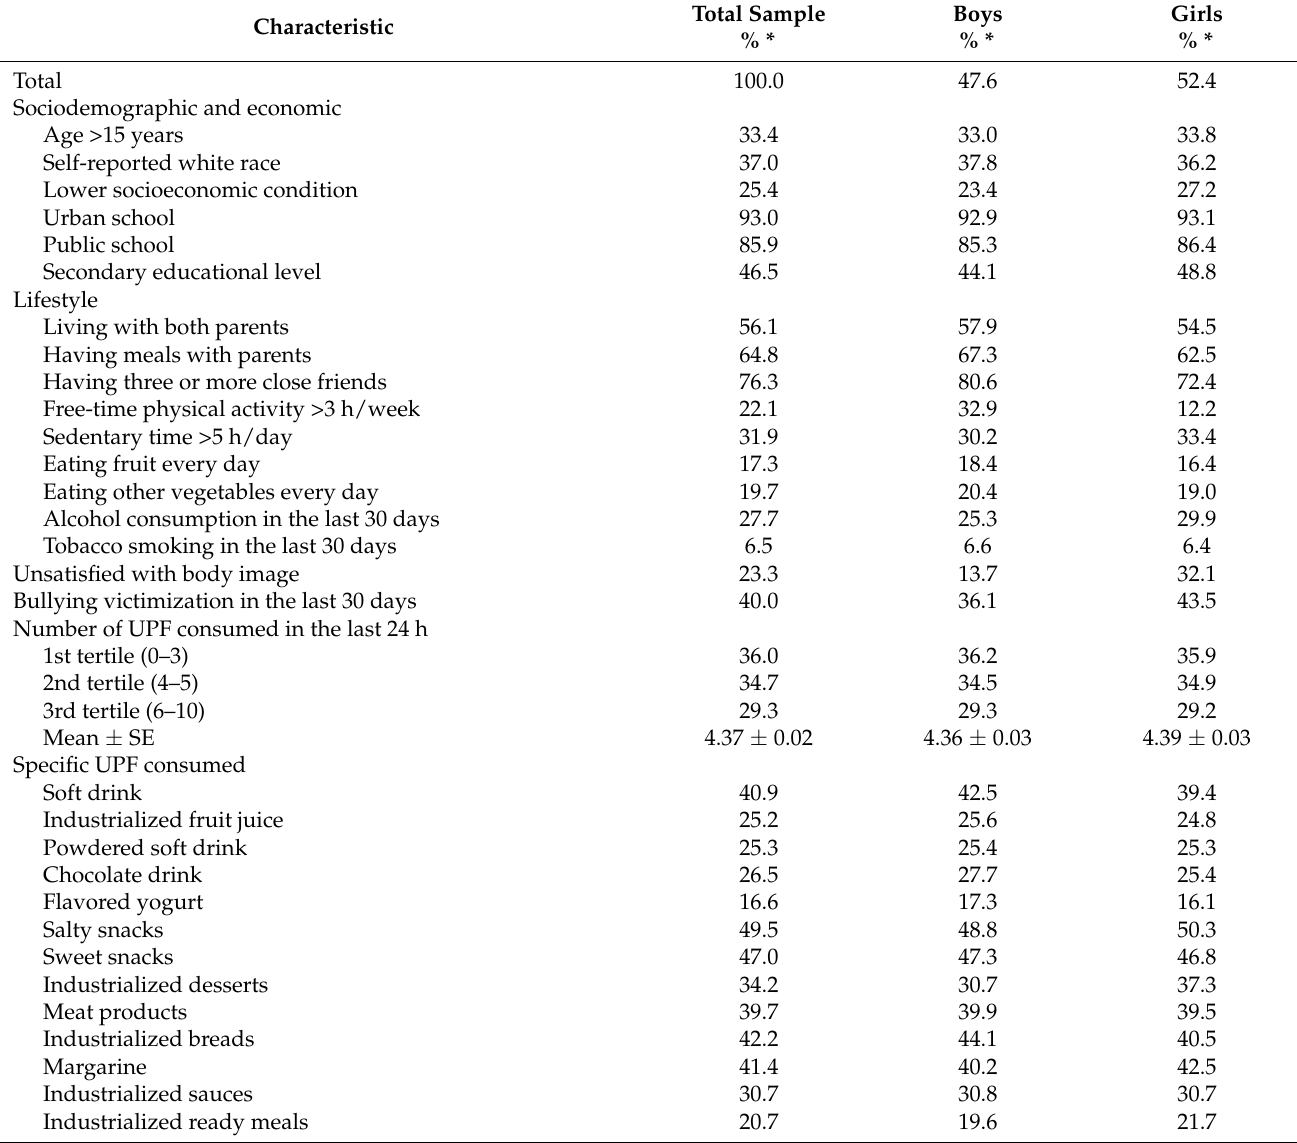
Table 1. Characteristics of adolescent students aged 13–17 years by sex, Brazil, 2019.